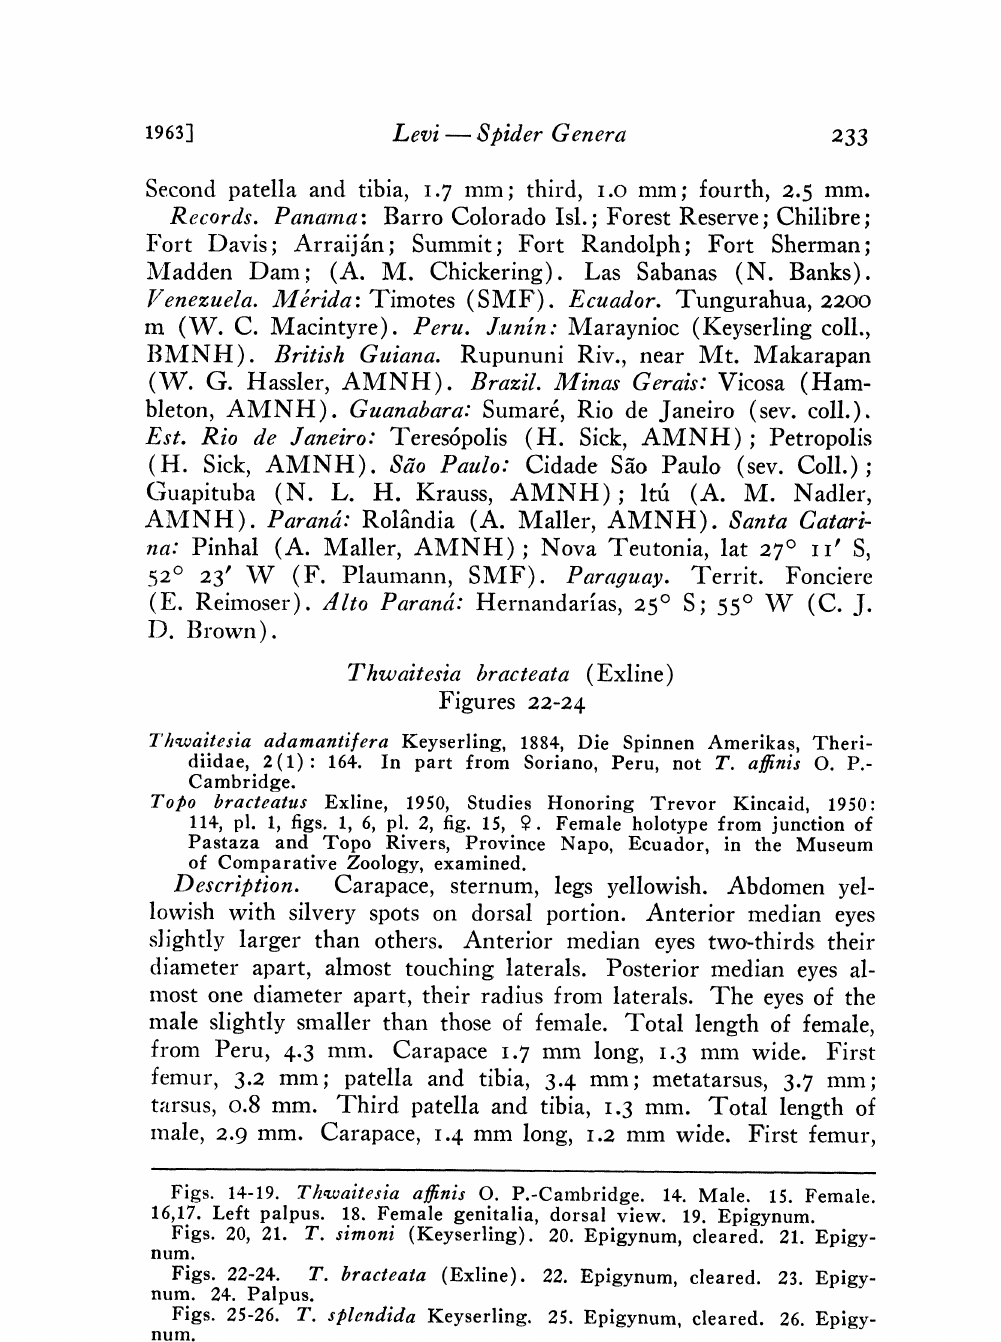
Figs. 14-19. Thvaitesia affinis O. P.-Cambridge. 14. Male. 15. Female. 16,17. Left palpus. 18. Female genitalia, dorsal view. 19. Epigynum. Figs. 20, 21. T. simoni (Keyserling). 20. Epigynum, cleared. 21. Epigy- rlum. Figs. 22-24. T. bracteata (Exline). 22. Epigynum, eleared. 23. Epigy- num. 24. Palpus. Figs. 25-26. T. splendida Keyserling. 25. Epigynum, cleared. 26. Epigy-